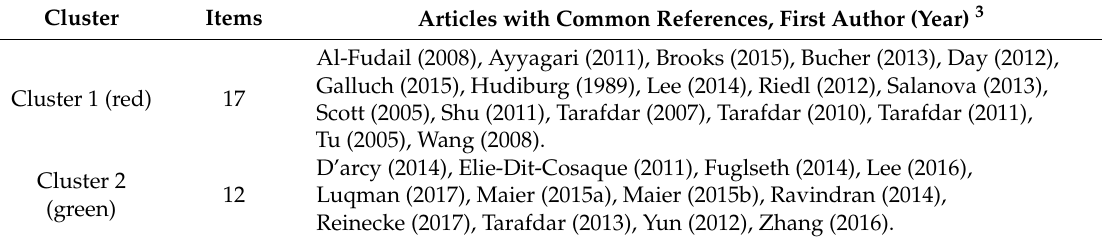
Figure 7. Bibliographic coupling graph. Table 5. Reference articles in the bibliographic coupling.